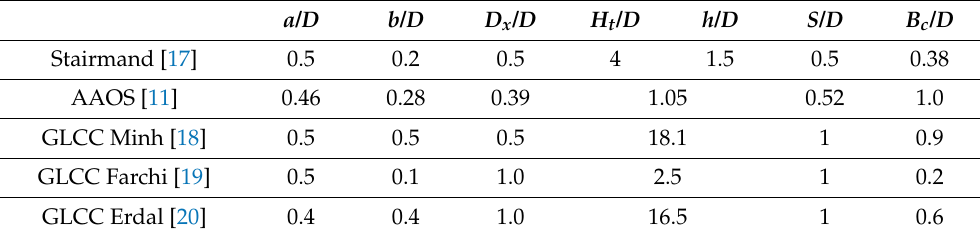
Figure 1. Cyclone separator configurations—main dimensions. Table 1. Separator geometric ratios.